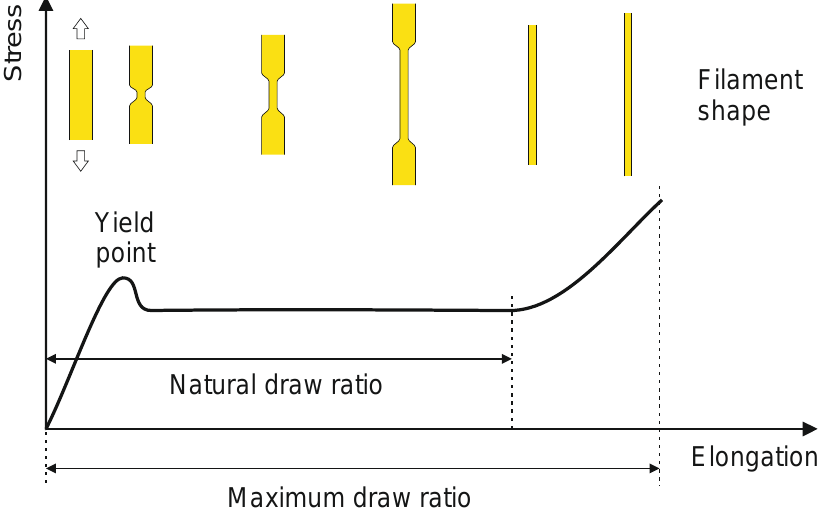
Figure 7. Stress-strain behavior of an as-spun filament.